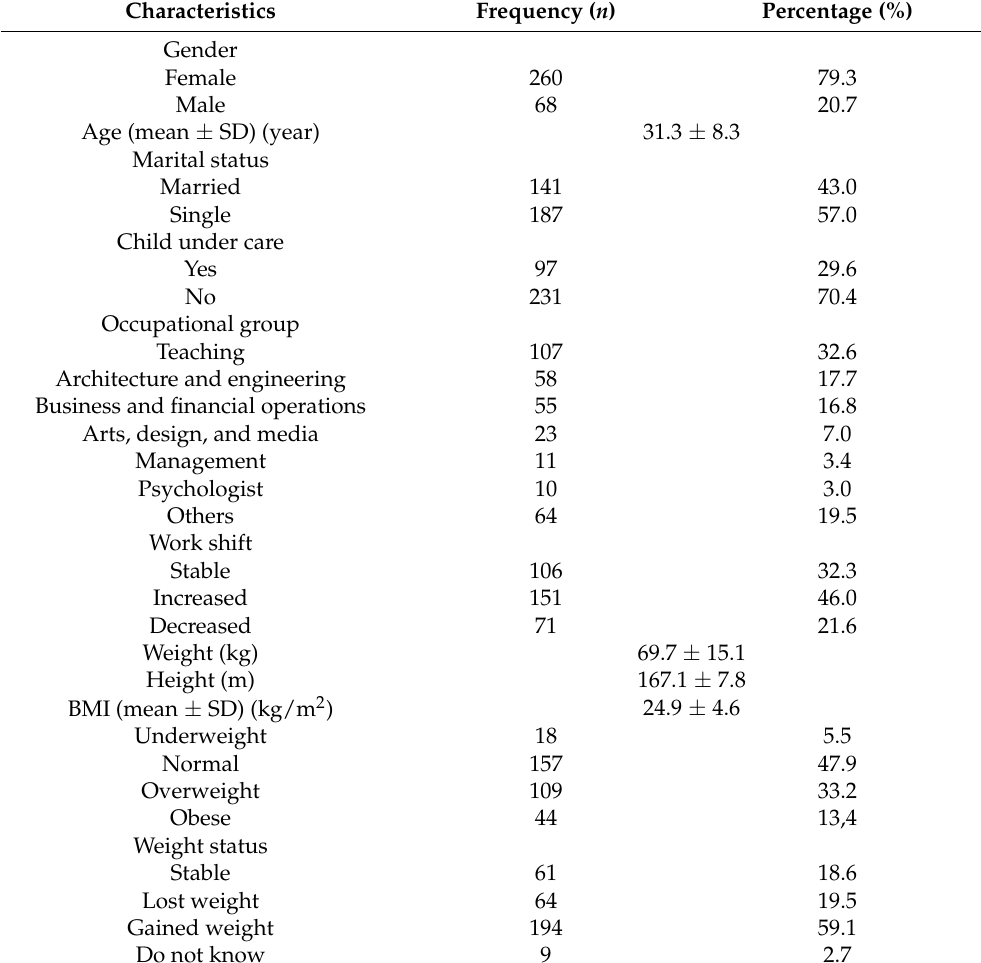
Table 1. Socio-demographic characteristics of the study participants ( n =